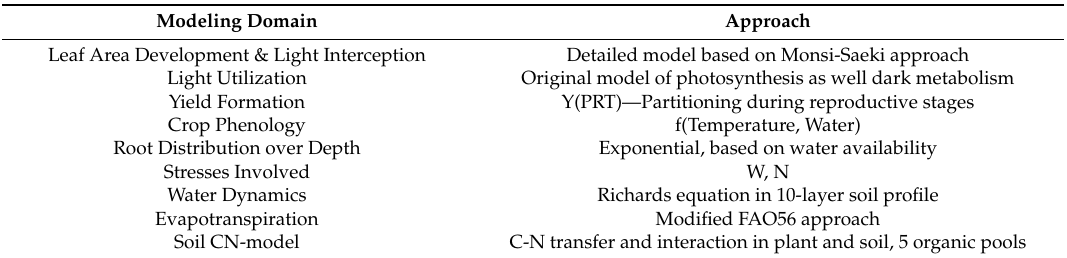
Table 1. Processes involved in AGROTOOL and the principal approaches of their implementation.